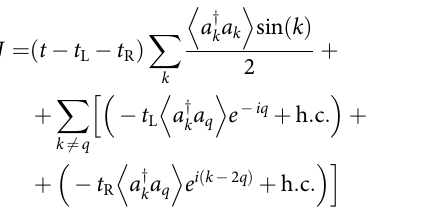
Figure 3 | Signatures of 8 p periodicity. ( a ) Current as a function of F for a system with N ¼ 10, with parameters 8 p (cid:4) o (cid:2) 1 (orange, solid), 8 p (cid:4) o (cid:2) 1 10 t (cid:2) 1 t L (cid:2) t R ¼ 10 (cid:2) 2 t L (black, dot dash) and 8 p (cid:4) o (cid:2) 1 J ¼ L ; height of the 8 p A 8 p ½ (cid:3)ð Þ and 4 p A 4 p ½ (cid:3)ð Þ peak of the FFT of the current profile over a range of model parameters. ( c ) Time evolution of the some of the k -components of the momentum distribution as a function of F for a system with N ¼ 10, with parameters t ¼ 10 t L ; D ¼ 10 : 1 t L ; 8 p (cid:4) o (cid:2) 1 t R (cid:2) t L ¼ 10 (cid:2) 4 t L (orange/triangles) and t R (cid:2) t L ¼ 10 (cid:2) 1 t L (blue/circles). ( d ) Same as in c with the time window F [0, 8 p ]